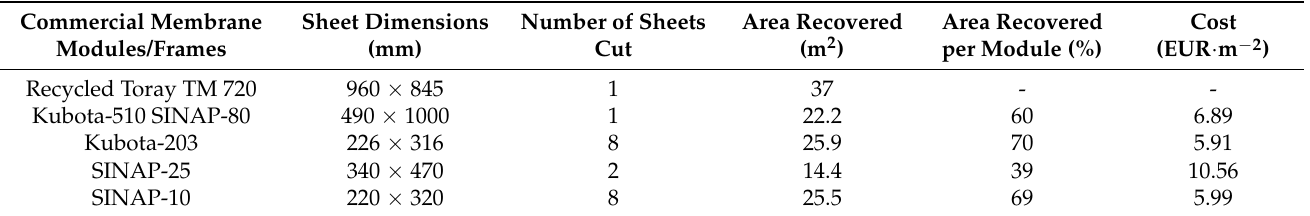
Table 5. Cost of the production of the r-UF for use in an aMBR depending on the targeted membrane frame